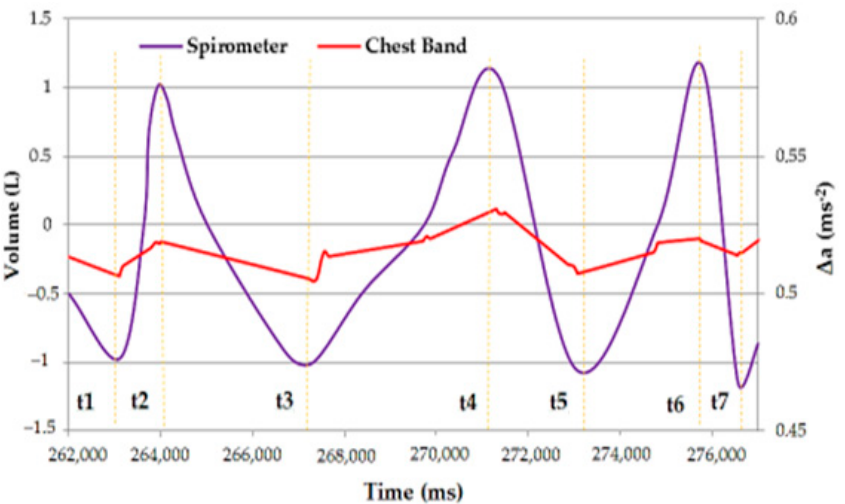
Sensors 2022 , 22 , x FOR PEER REVIEW 20 of 31 Figure 9. Comparison between the time trend inhaled/exhaled air volume and differential accelera- tion signal acquired using the chest band; the peaks in inhaled/exhaled air volume are highlighted.